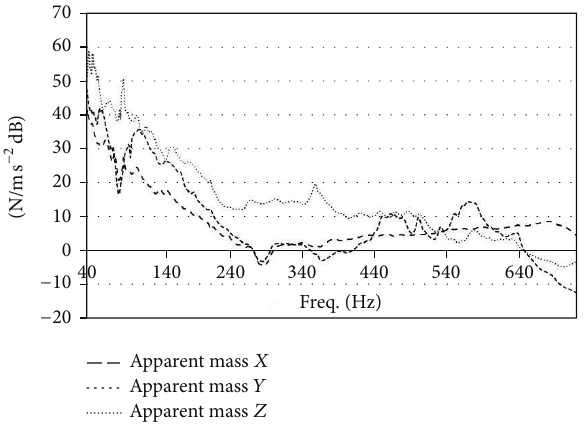
Figure 4: Apparent mass of RH mount region.